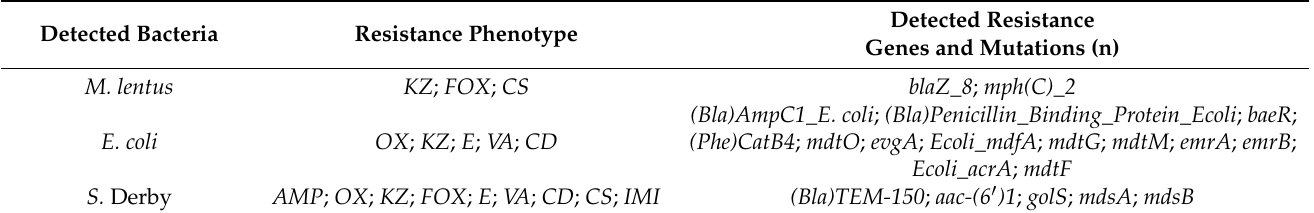
Table 2. Strains identified with combinations of phenotypic 1 and genetic resistance 2 to different antibiotics.